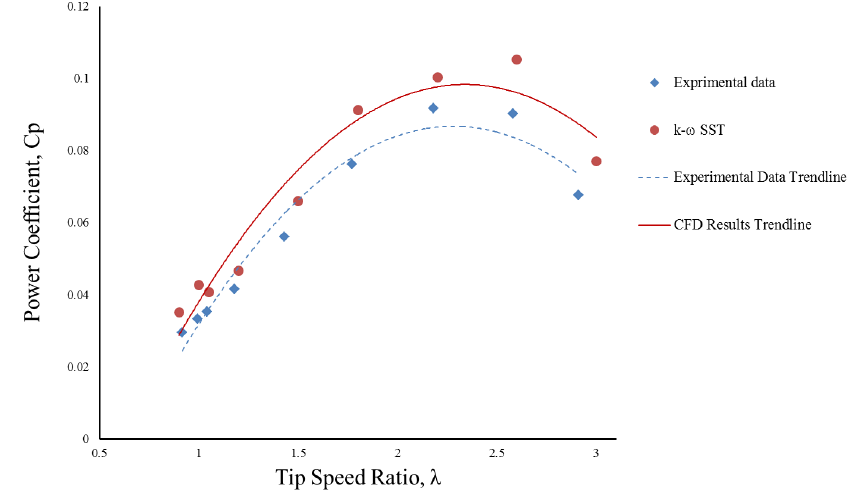
Figure 8. Power coefficients obtained by computational fluid dynamics (CFD) simulation and experimental result.